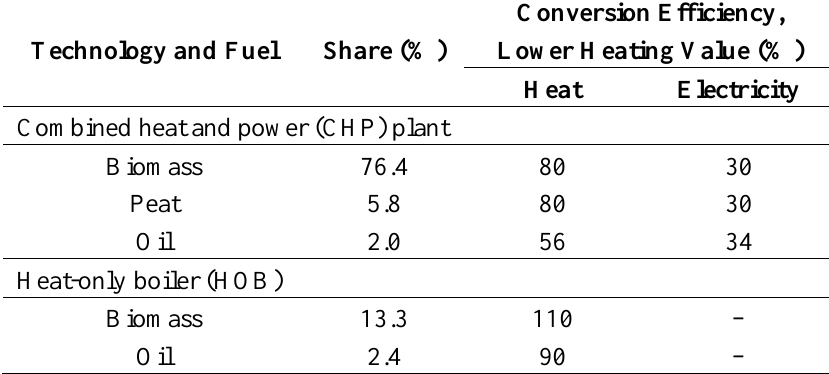
Table 3. Share of different production technologies and their conversion efficiencies in the district heating (DH)-CHP production plant in Växjö,